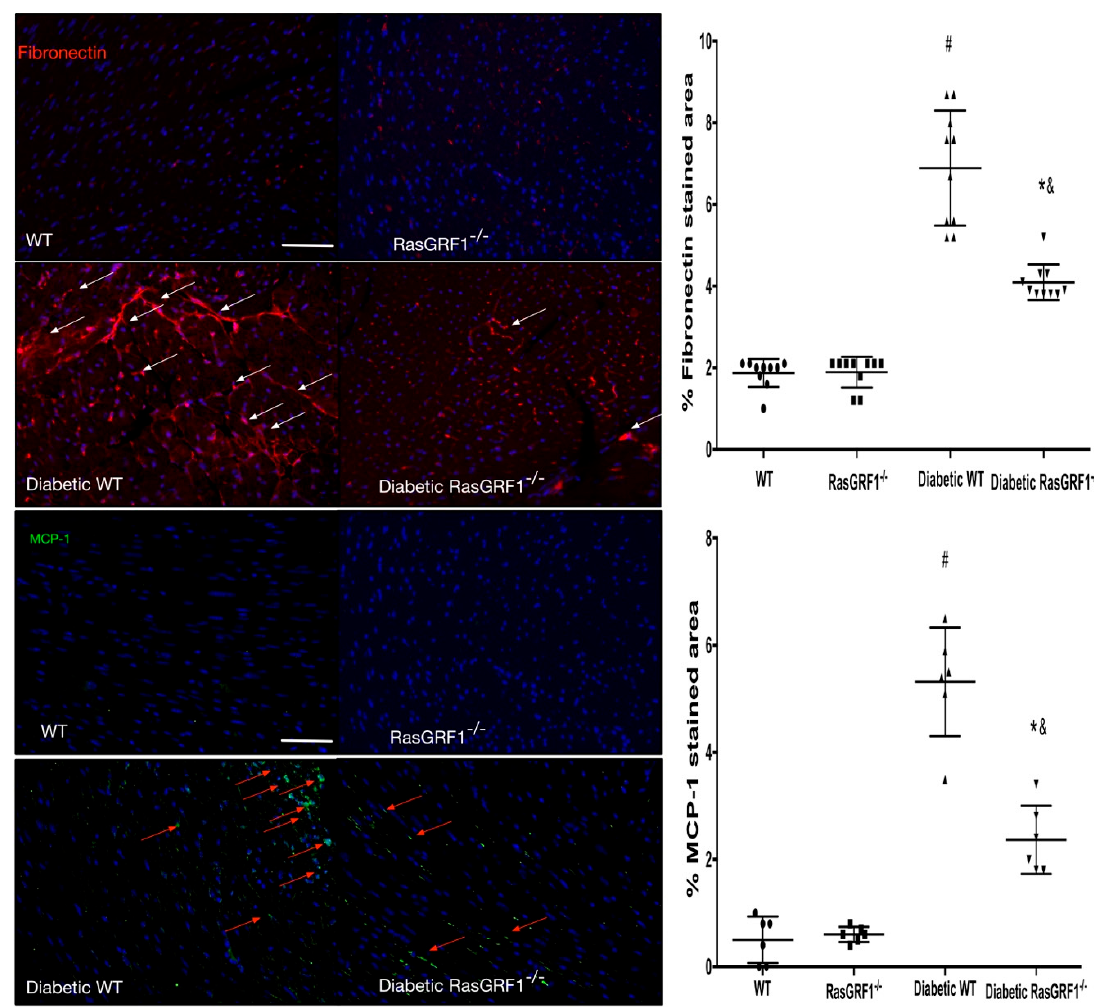
Figure 5. Effects of RasGRF1 knockout on the expression monocyte chemoattractant protein-1 (MCP-1) and fibronectin in diabetic mice. Tissue sections were stained with dual immunofluorescence staining for MCP-1 expressing and fibronectin expression cells. The control mice received saline ( n = 4 WT, n = 4 RasGRF1 − / − ; no difference between these two groups was observed); diabetic WT and RasGRF1 − / − mice (each group n = 4). The white arrow indicated a fibronectin positive area, and the red arrow indicated the MCP-1 positive cells. Diabetic RasGRF1 − / − mice in an attenuated chronic diabetic condition induced interstitial collagen deposition and the expression of pro-inflammatory cytokines compared to diabetic WT mice. # p < 0.01 vs. normal WT and normal RasGRF1 − / − mice; * p < 0.05 vs. diabetic WT mice. & p < 0.05 vs. normal WT and normal RasGRF1 − / − mice. Scale bar = 200 μ m.